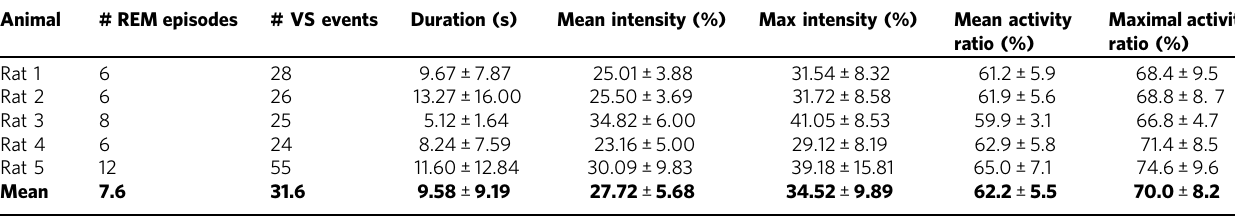
Table 1 Variability of vascular surges (VS) events across animals